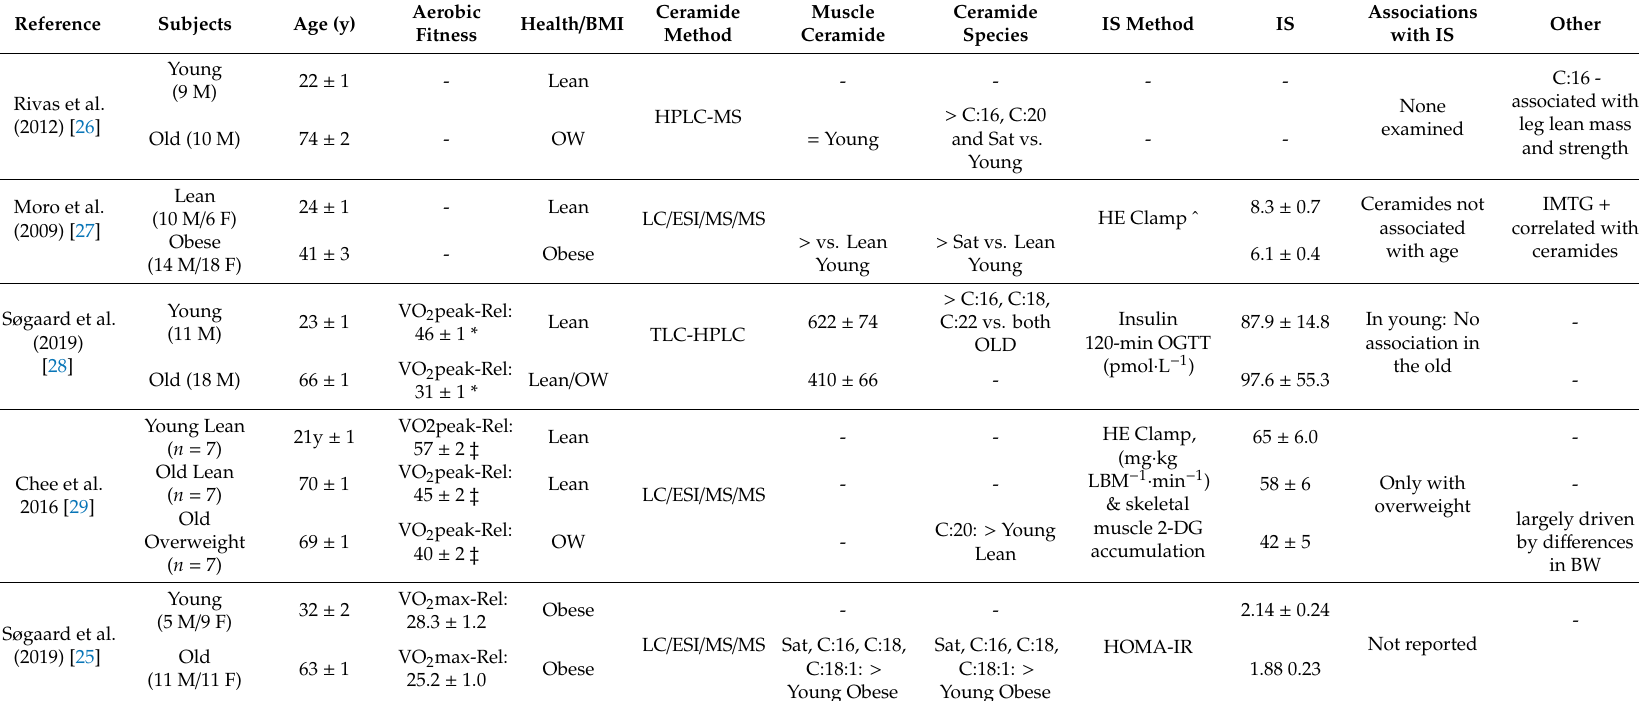
Table 1. Cross-sectional studies in aging humans at